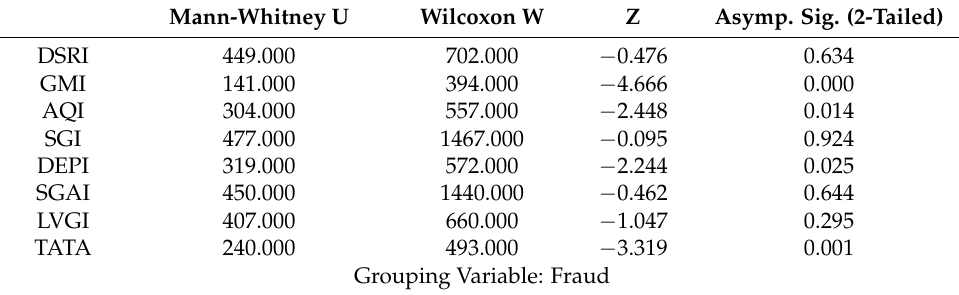
Table 2. Independent group comparison of the Beneish score components—results of the Mann- Whitney